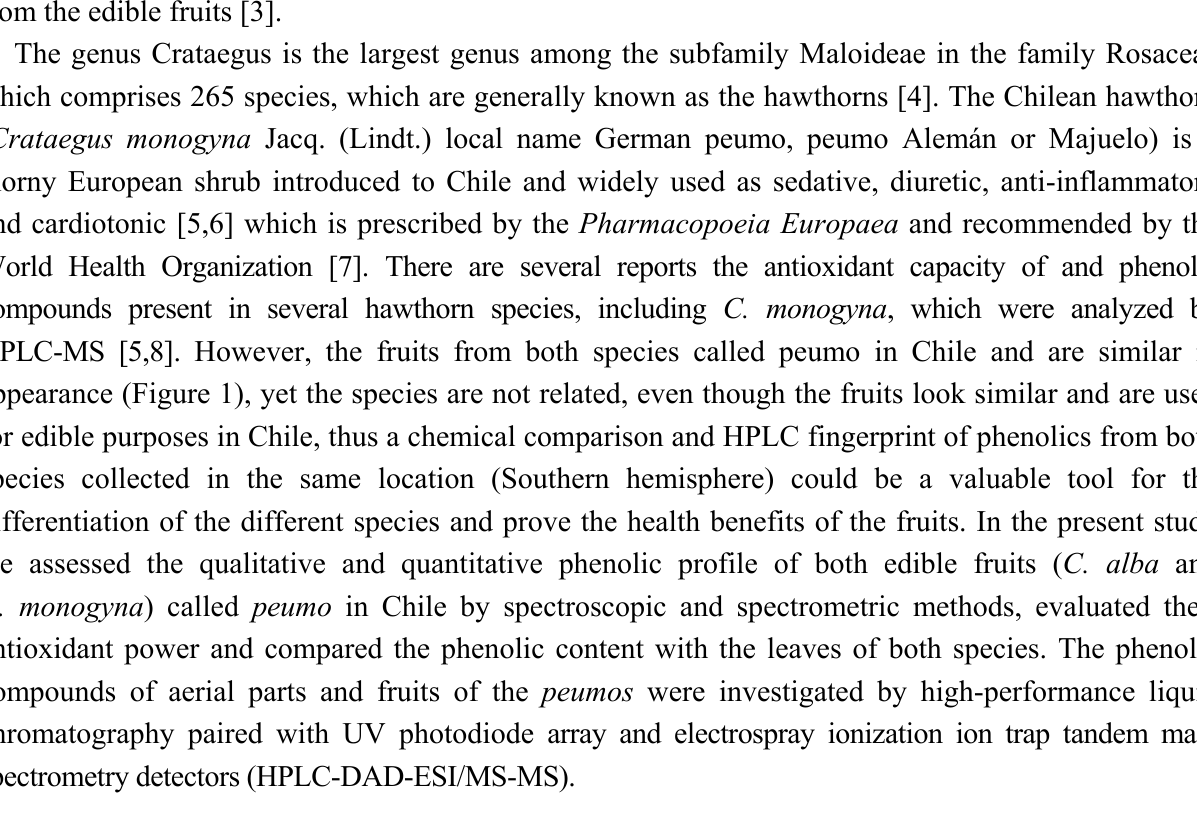
Figure 1. Pictures of ( a ) Chilean peumo ; ( b ) German peumo collected in Re-Re,